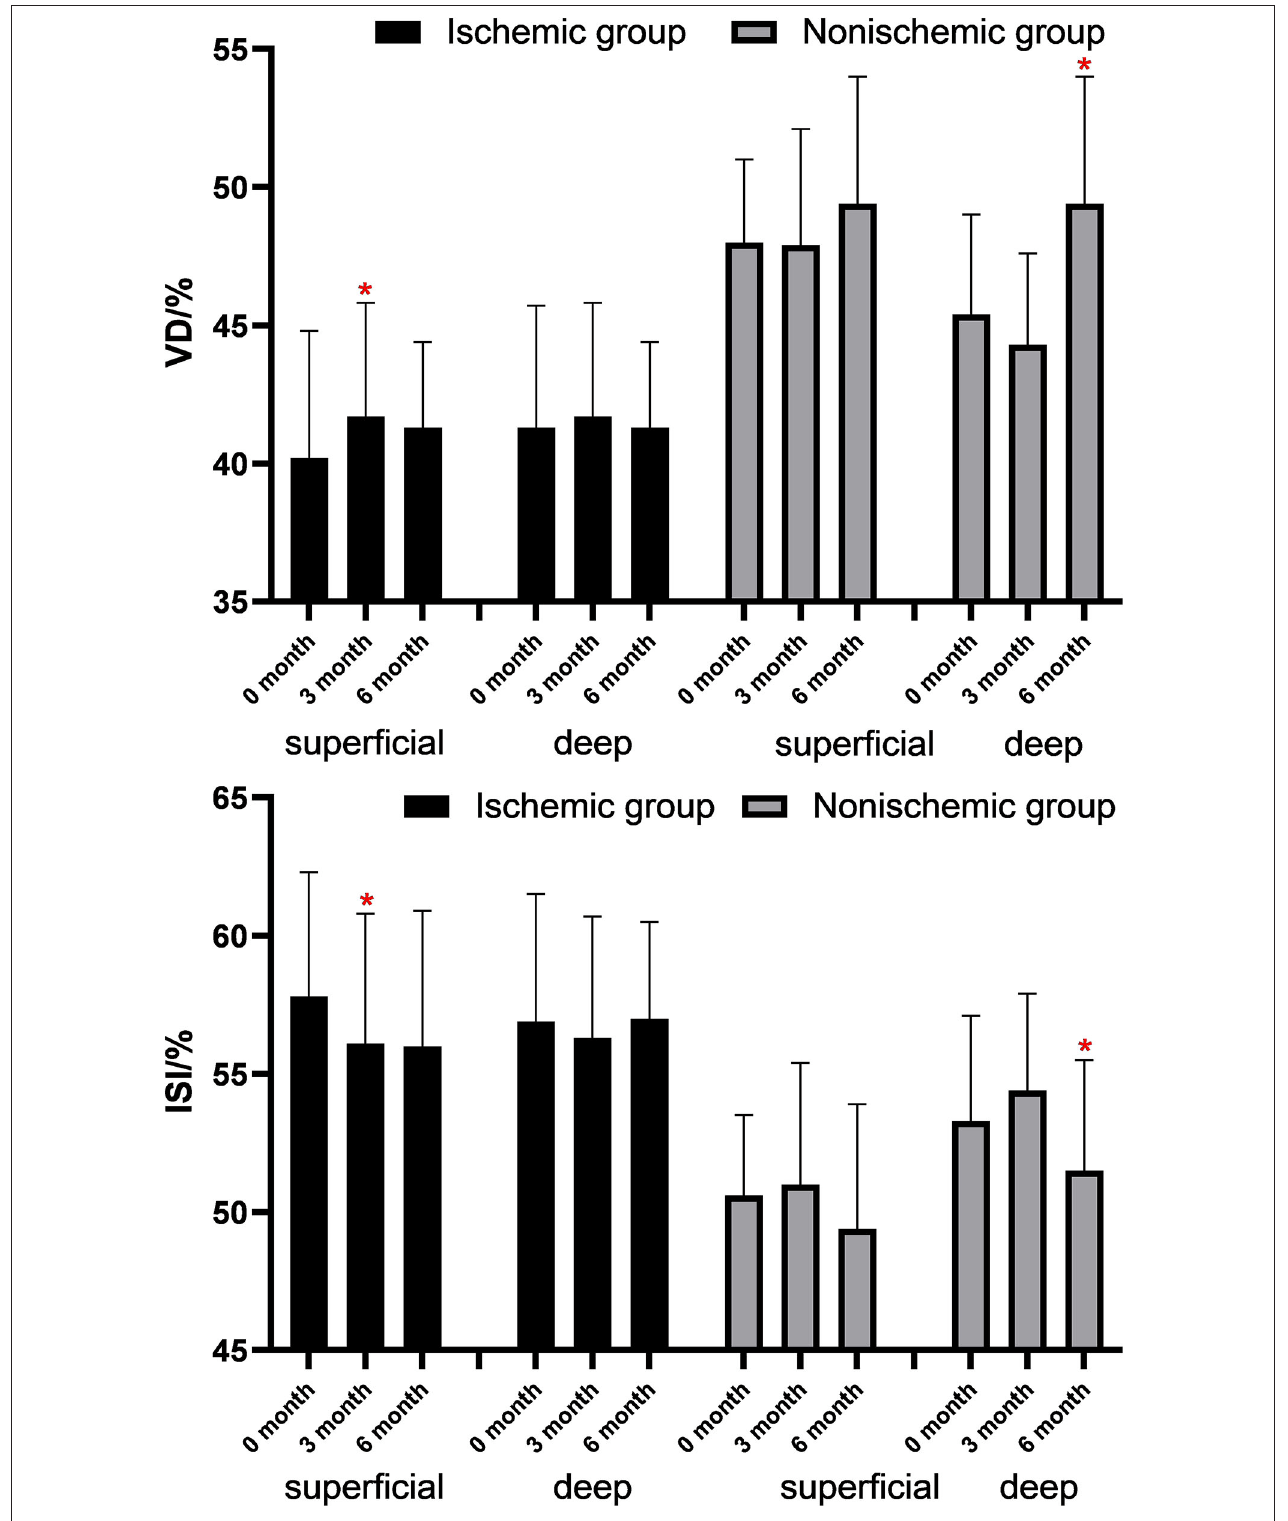
FIGURE 2 | Changes of VD and ISI in the macular ischemia group after antivascular endothelial growth factor (VEGF) treatment. * p < 0.05.